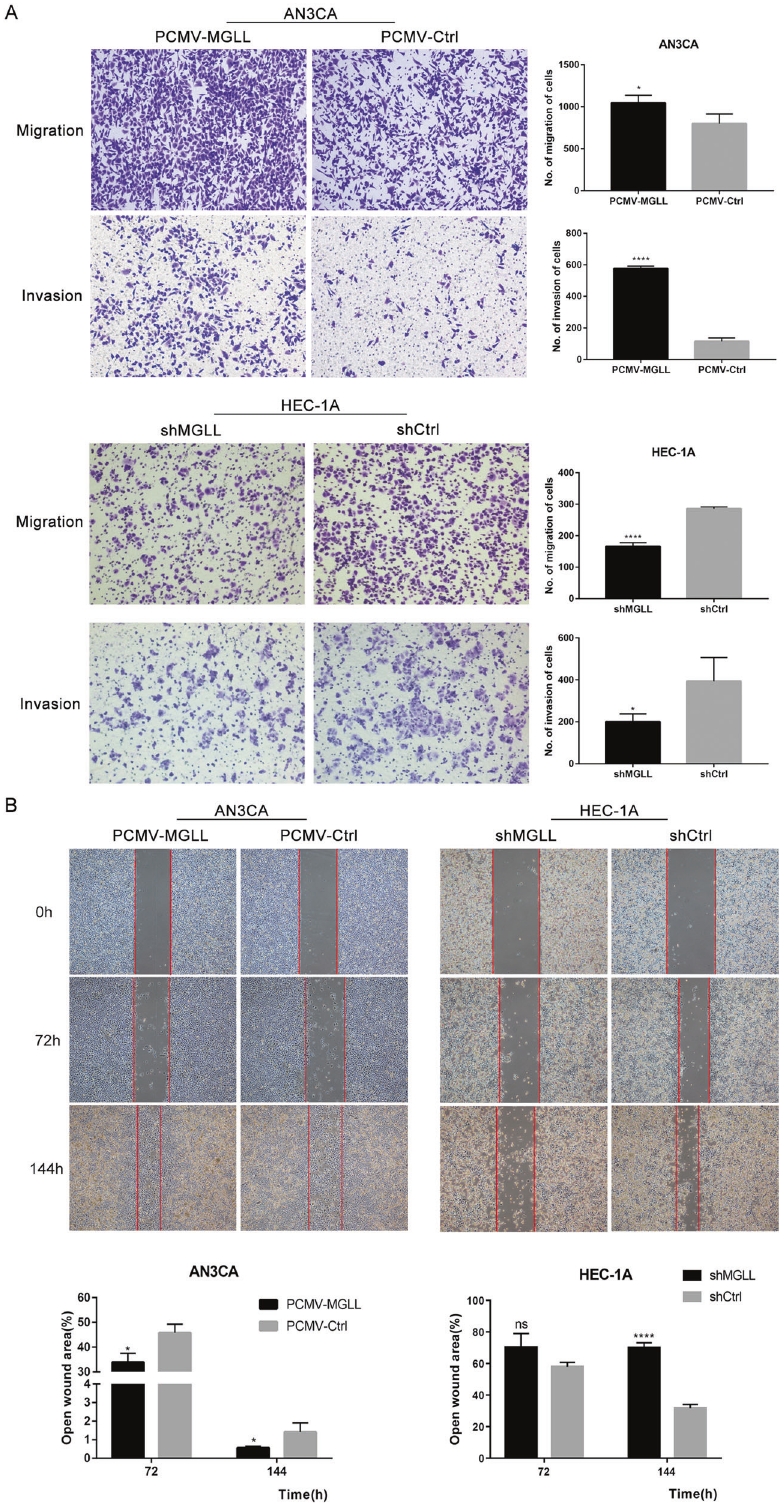
Fig. 3 MGLL enhances the invasion and migration of EAC cells. A Capacity of migration and invasion after deletion or overexpression of MGLL in EAC cells by transwell assay. B Ability of migration after deletion or overexpression of MGLL in EAC cells by wound healing assay. C Expression of E-cadherin, N-cadherin, vimentin, β -catenin, zo-1, and claudin-1 were determined by Western blot assay in EAC cells after overexpression or knockdown of MGLL. All experiments were repeated three times at least. * P < 0.05, ** P < 0.01, *** P < 0.001 and **** P < 0.0001 for statistical analysis of the indicated